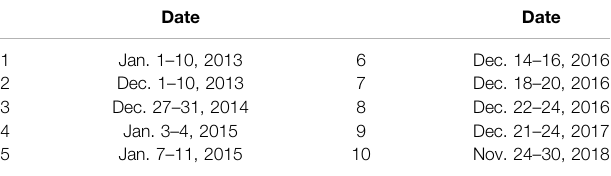
TABLE 1 | 10 heavy haze episodes in the past few